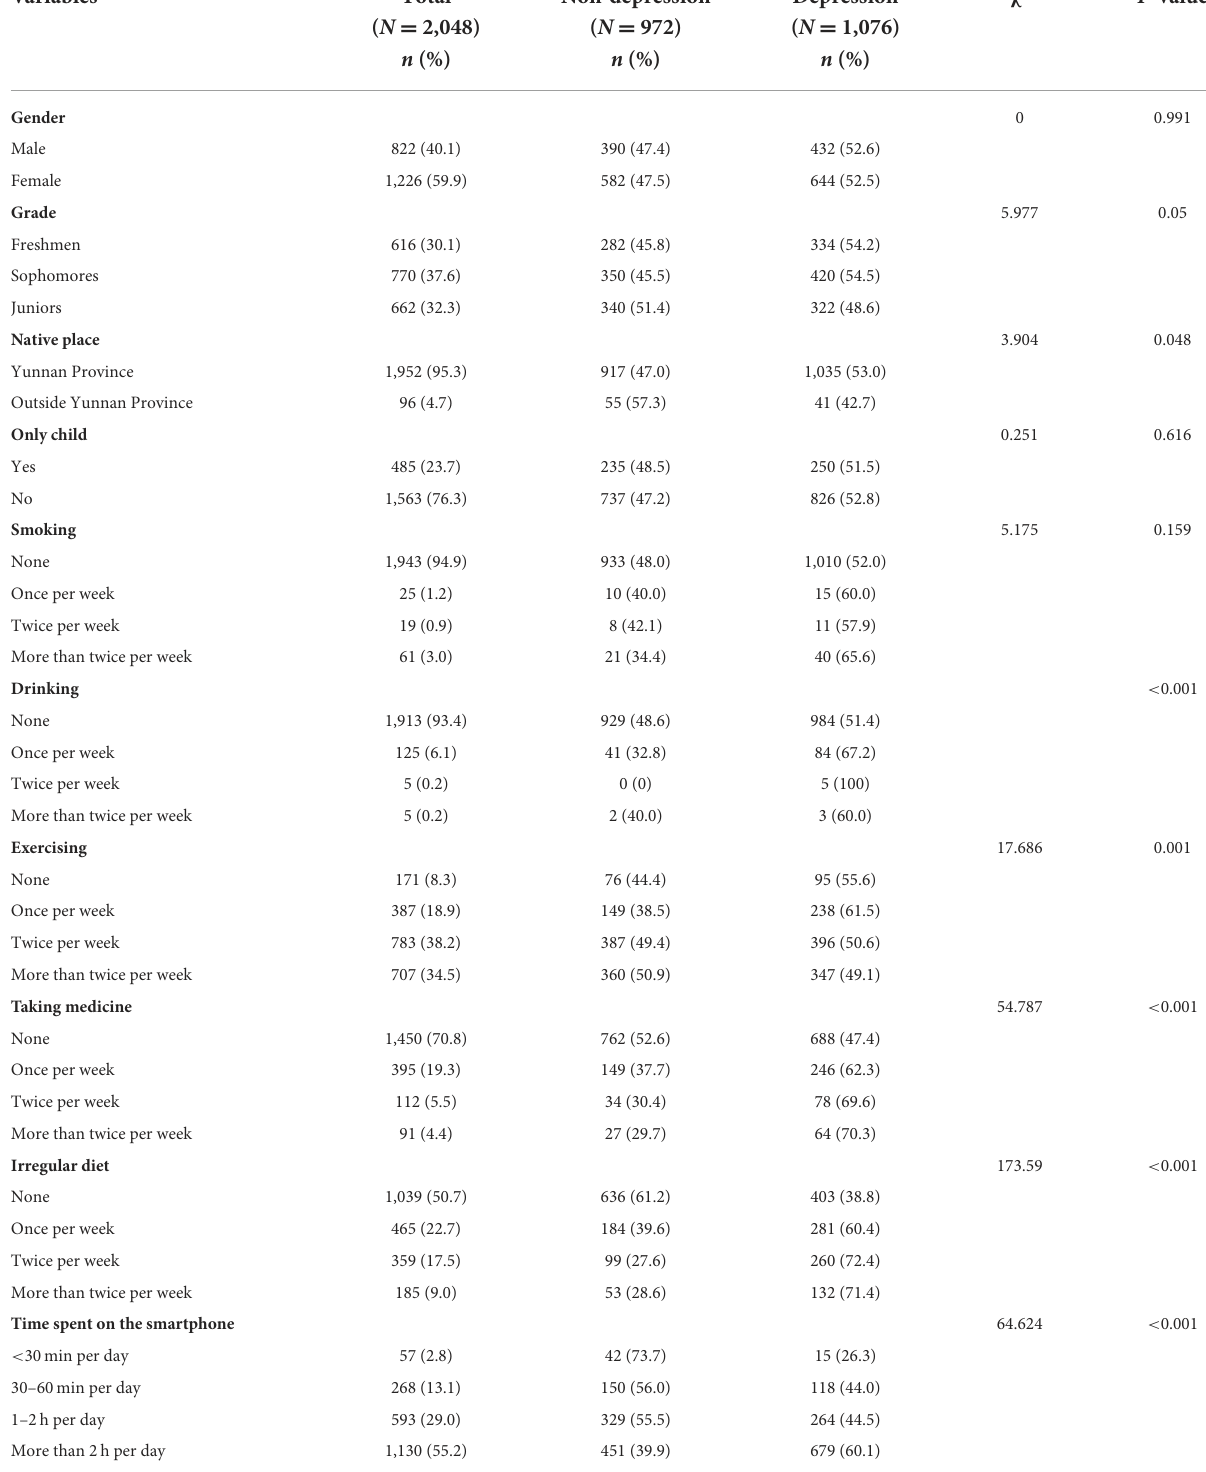
TABLE 1 Characteristics of enrolled students divided into non-depression and depression groups ( N =